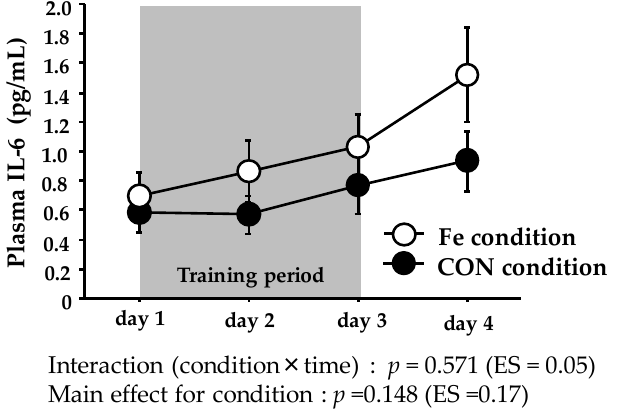
Figure 2. Plasma IL-6 levels during days 1–4. The values are means ± SE.